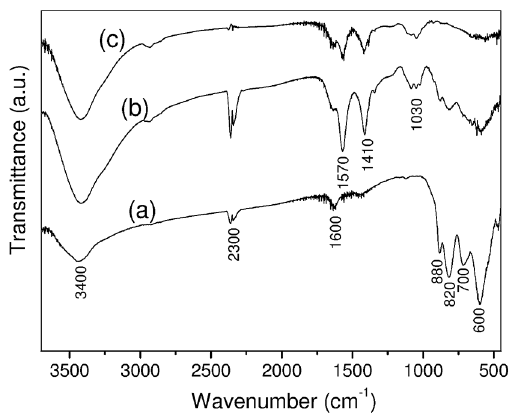
Figure 5: FTIR spectra of (a) ZnWO enzyme on the ZnWO